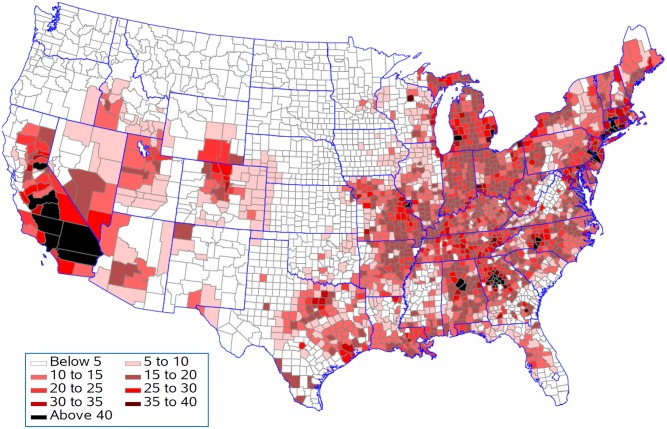
Increase in death from all causes (per 100,000 population per year) resulting from being above the regional 25th percentile for each pollutant.